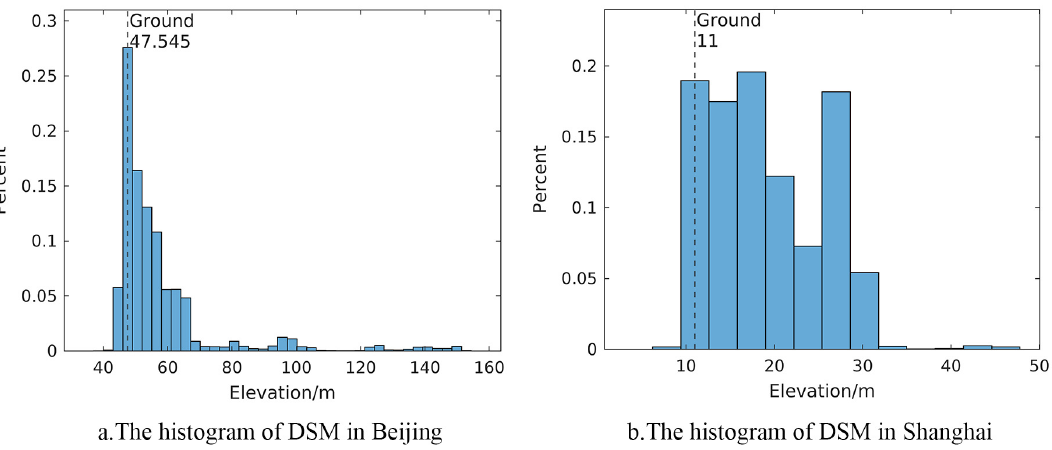
Figure 4. The histogram h S in two experimental regions (Beijing and Shanghai). The ground elevation is computed by the principle mentioned above.